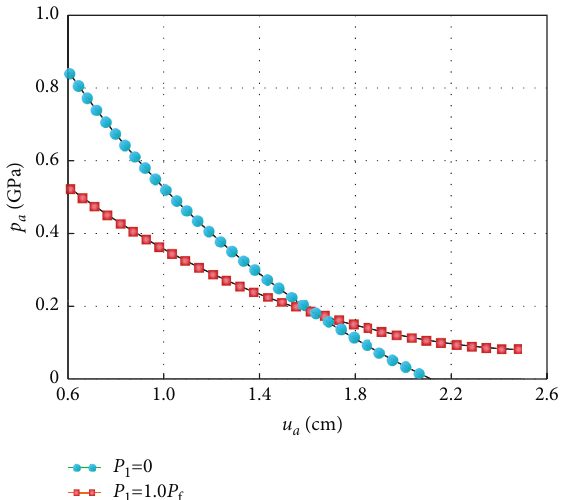
Figure 5: Characteristics of surrounding rock under different drainage conditions.